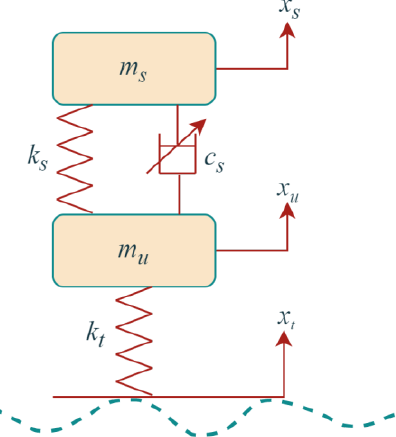
Figure 3. The 1/4 vehicle suspension model diagram.